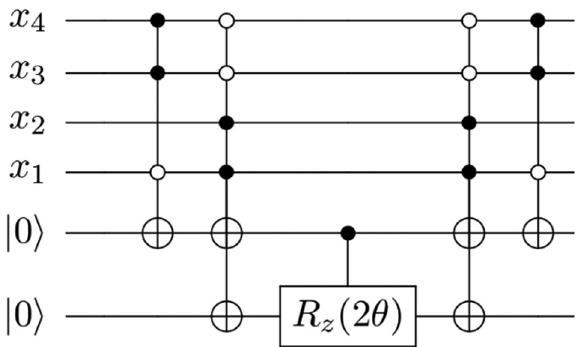
Fig. 5 Circuit C j θ j . The circuit when M θ ¼ fð 1 ; 1 ; 0 ; 0 Þ ; ð 1 ; 1 ; 1 ; 0 Þg and M (cid:2) θ ¼ fð 0 ; 0 ; 1 ; 1 Þg